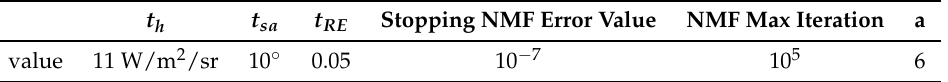
Table 6. HBEE-LSNMF parameter values for the Basel data set.